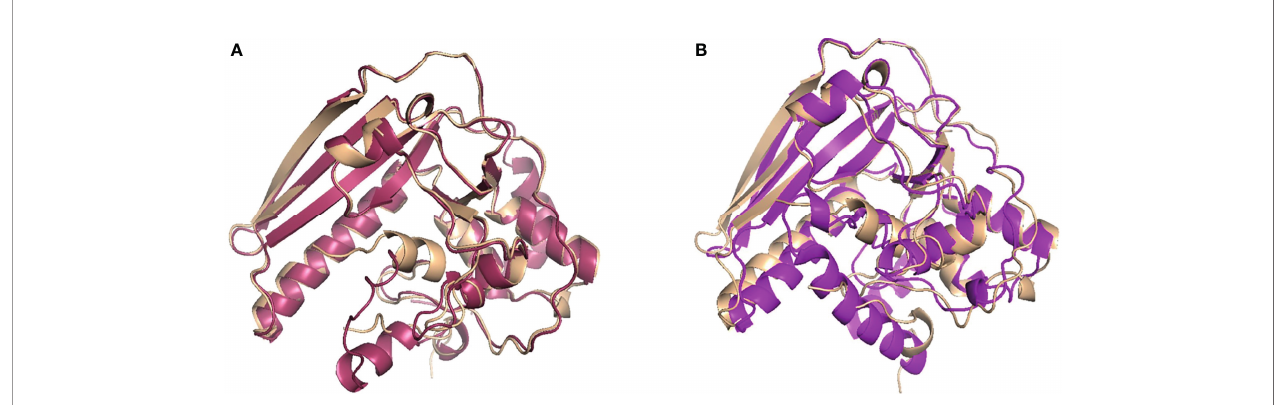
FIGURE 4 | Comparative and de novo modeling of PsxA aligned with PtxA. (A) Rosetta CM comparative modeling of B. pseudohinzii PsxA (pink) based on B pertussis PtxA, aligned with B pertussis PtxA (tan). RMSD=0.602 Å, con fi dence= 0.74. (B) RoseTTAFold de novo modeling of B. pseudohinzii PsxA (purple) aligned with B pertussis PtxA (tan). RMSD= 1.655 Å, con fi